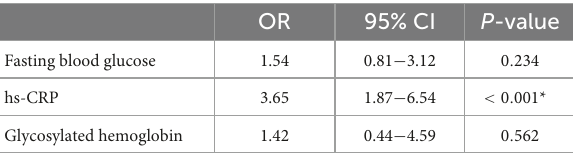
TABLE 5 Logistic regression analysis of fasting blood glucose, hs-CRP and glycosylated hemoglobin among multiple groups. OR